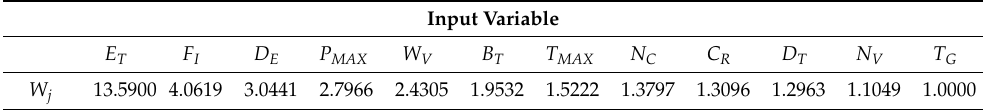
Table 7. Global sensitivity analysis of the MLP 22-10-3 artificial neural network.